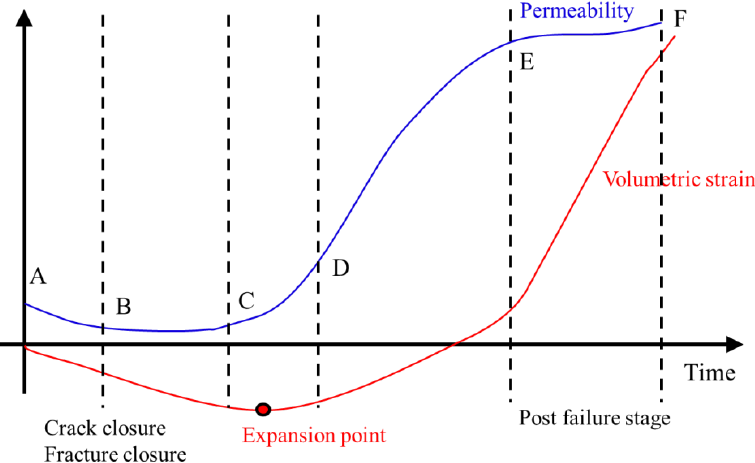
Figure 18. Schematic diagram for evolution of permeability and volumetric strain versus time.